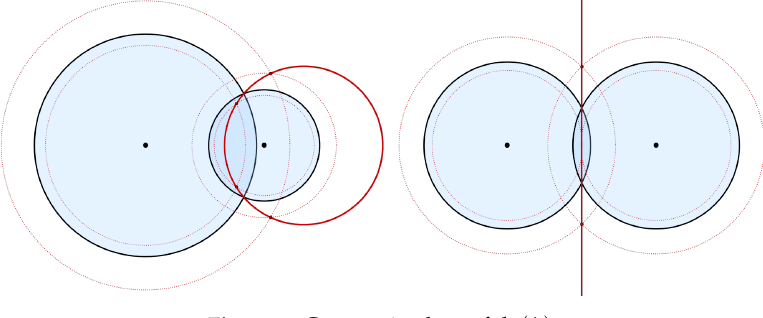
Figure 4. Geometric place of d ij ( λ )